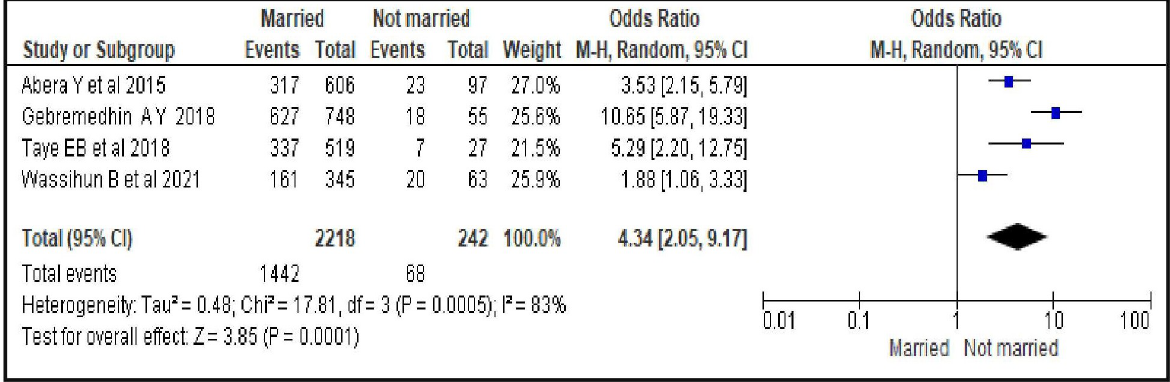
Fig 3. Association between women’s marital status and modern contraceptive uptake during postpartum period, 2021.